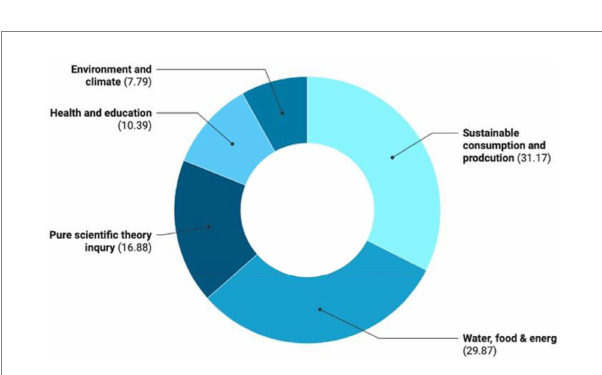
FIGURE 3 Themes of STEM teaching projects were developed by the surveyed teachers. The percentage is calculated using a total of 77 projects.